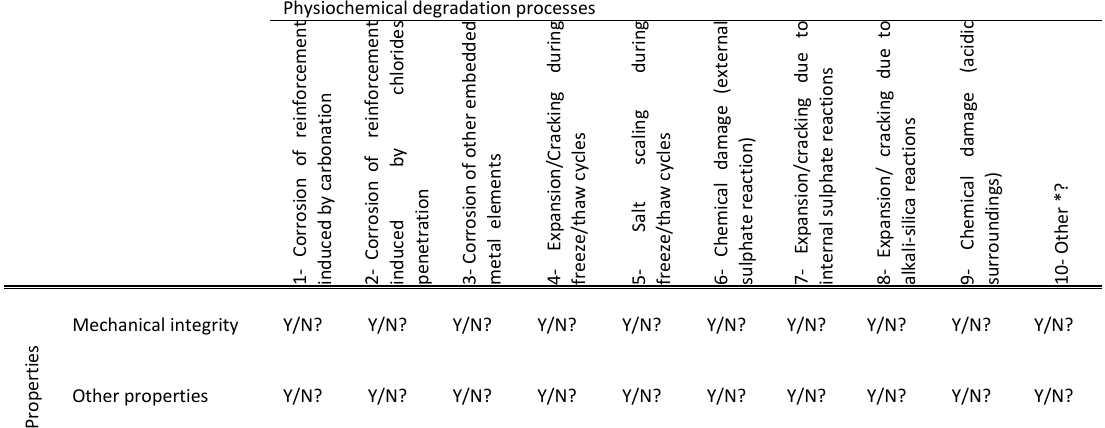
Table 1. List of performance loss risks for the invention. Physiochemical degradation